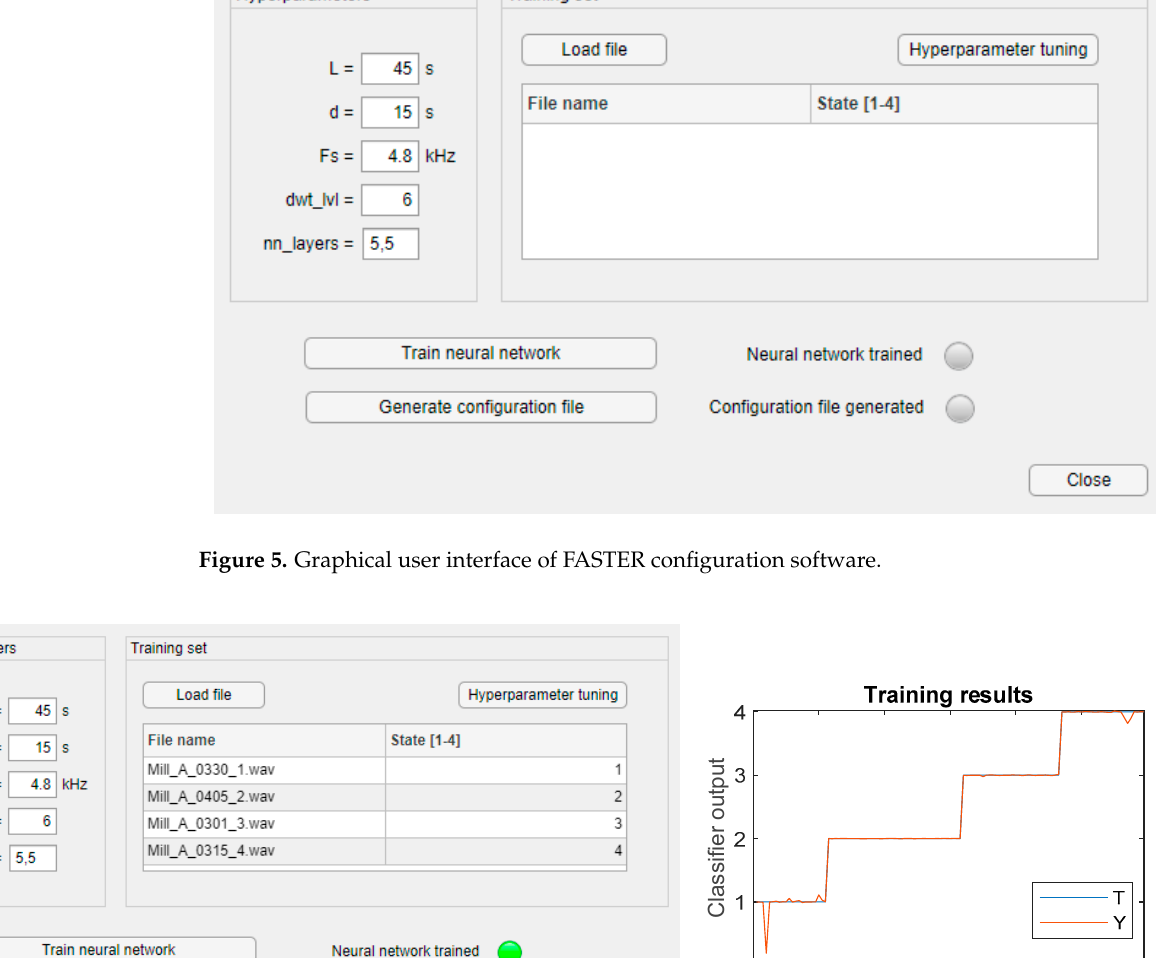
Figure 5. Graphical user interface of FASTER configuration software.